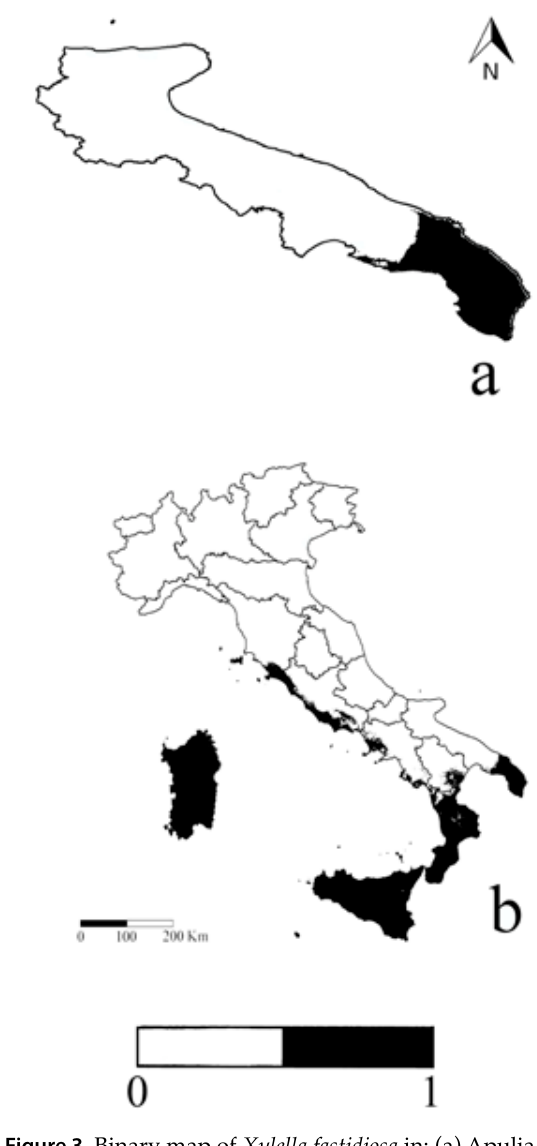
Figure 2. Species distribution models of Xylella fastidiosa in: Apulia (a) calibrated with Apulia records only; and Italy (b) calibrated with presence records from Apulia.